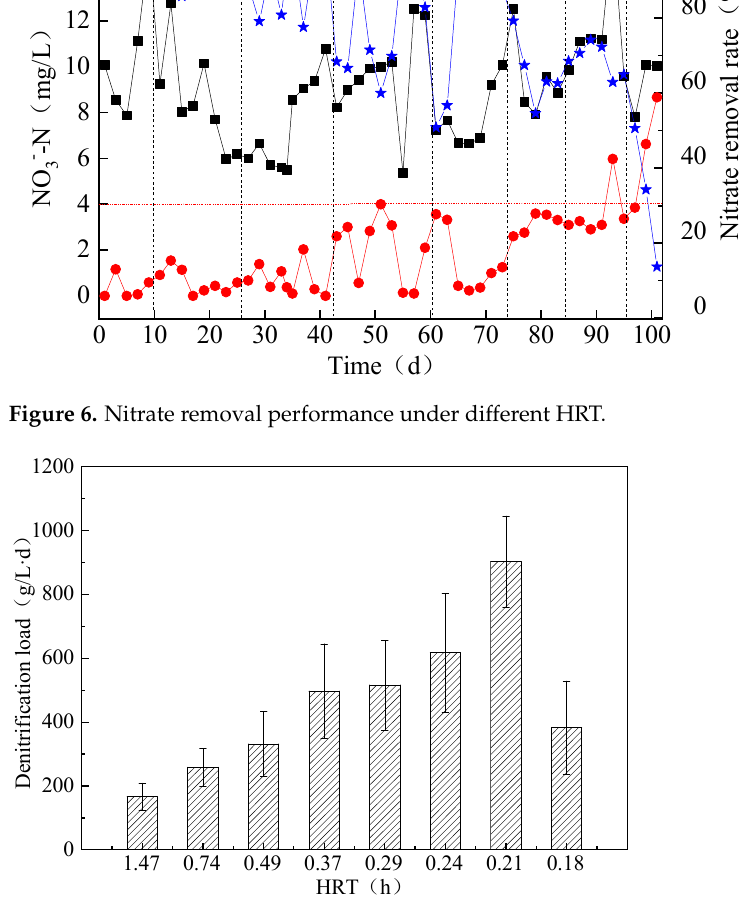
Figure 7. Nitrogen removal loading under different HRT.